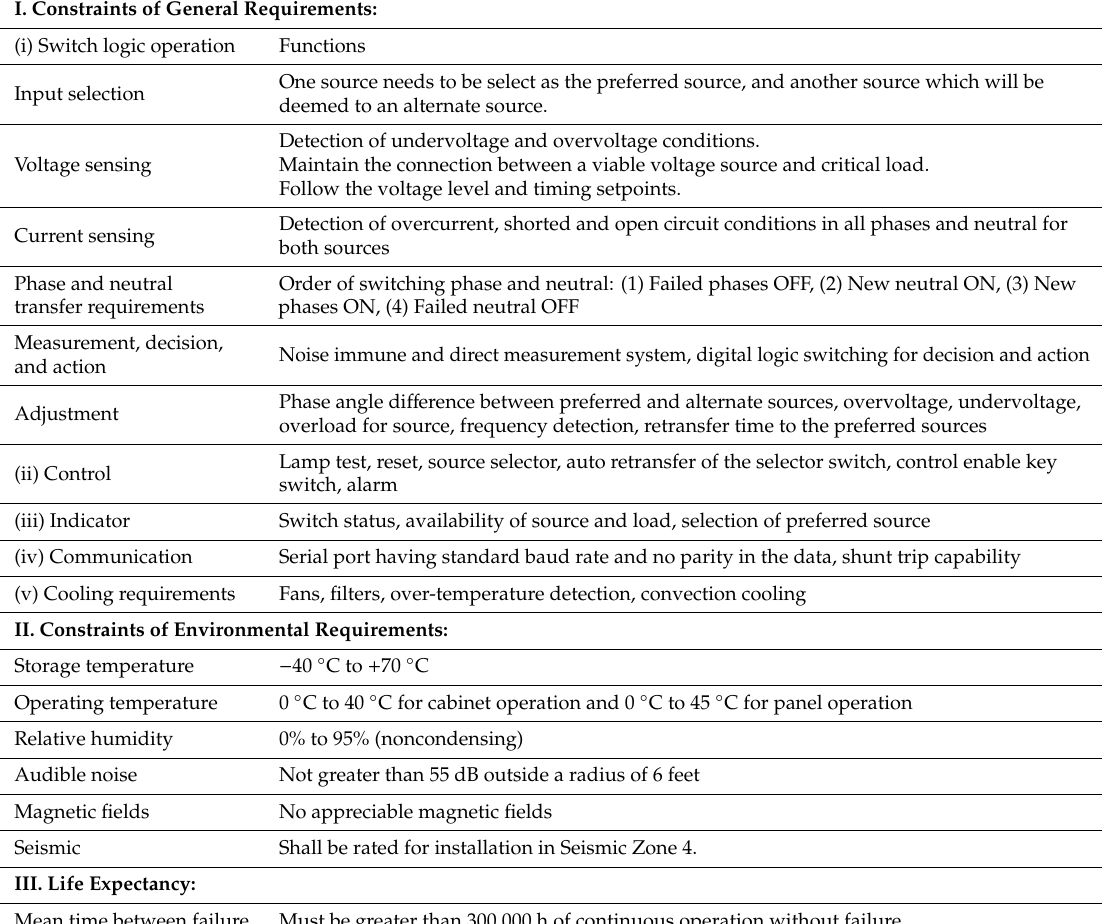
Table 1. Requirements for designing the